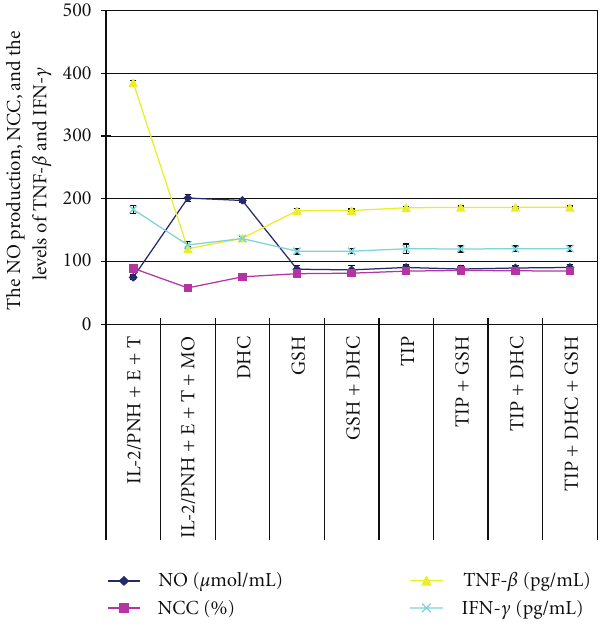
Figure 2: The e ff ect of di ff erent combinations of RNM scavengers on the activity of NK cells. Di ff erent combinations of RNM scavengers did not enhance the antineoplasmic activity of NK